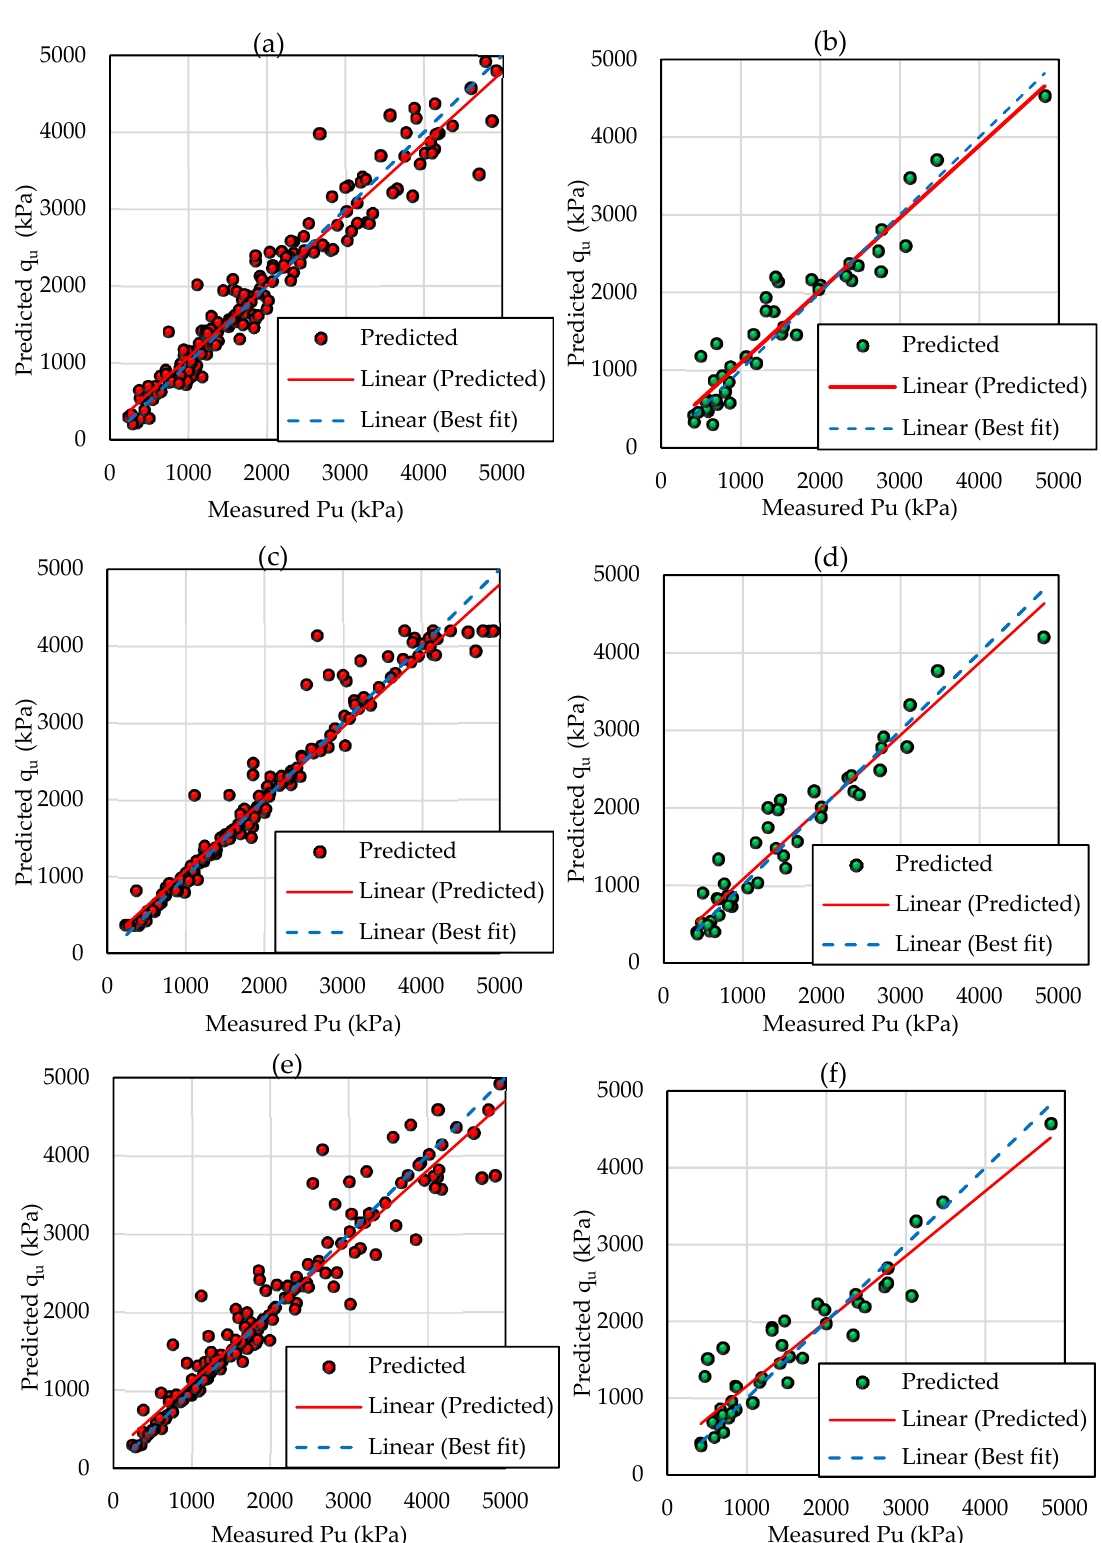
Figure 11. Measure and predicted values of unconfined compressive strength (UCS) of cement-stabilized soil using the training set: ( a ) gradient boosting (GB); ( c ) ANN and ( e ) support vector machine (SVM) and testing set: ( b ) GB; ( d ) ANN and ( f ) SVM.